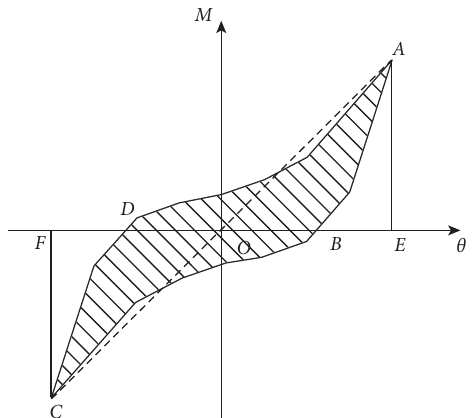
Figure 13: Computing sketch of viscous damping ratio.